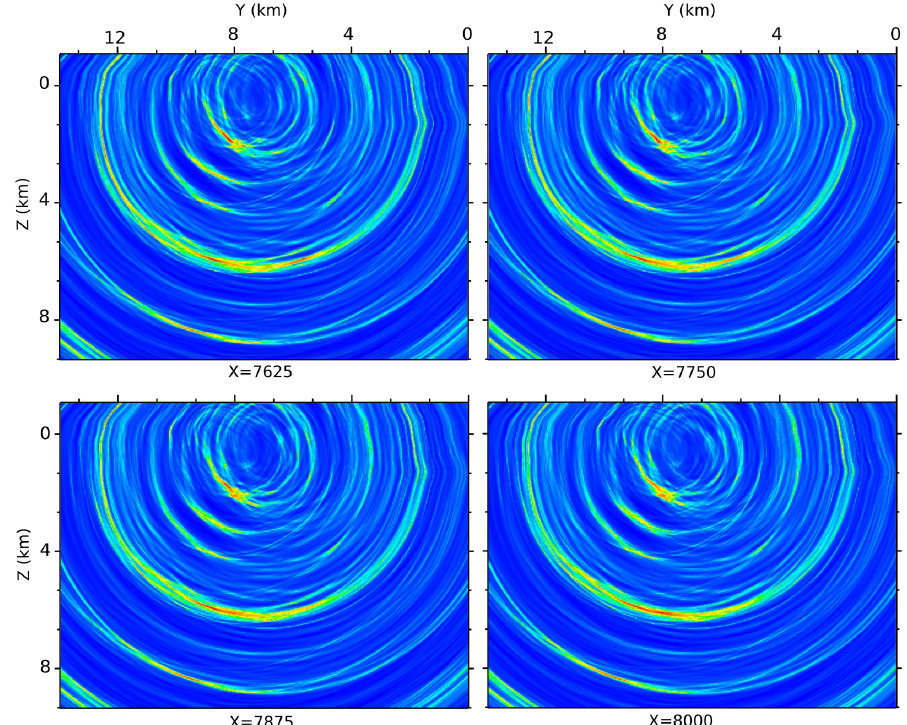
Figure 10. Sequential slices over a 375m interval in the x direction through the coherency image cube.